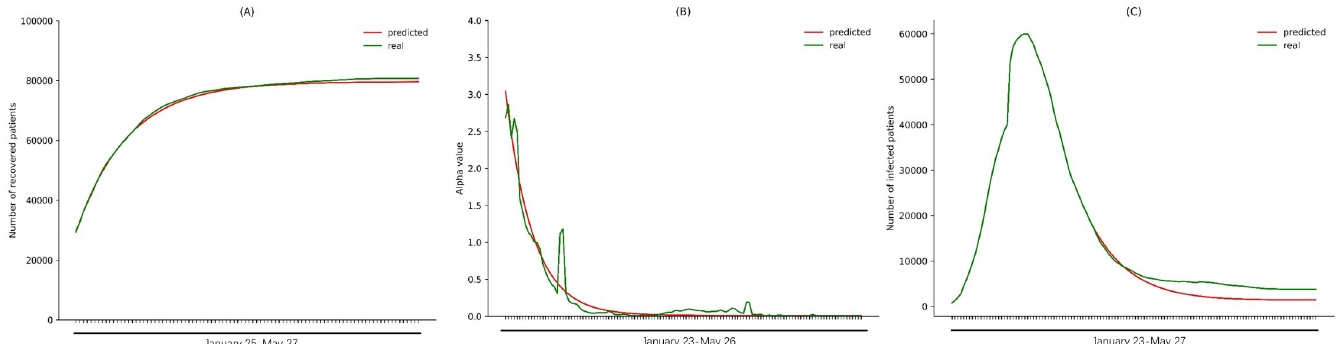
Fig 5. Comparison of predicted and actual numbers of epidemic patients in China. (A) The φ values from January 25 to March 10 were fitted to predict the φ values for China from March 11 to May 27. (B) The α values from January 23 to March 10 were fitted to predict the α values for China from March 11 to May 26. (C) The predicted α values and φ values were used to calculate the numbers of infections in China from March 12 to May 27.